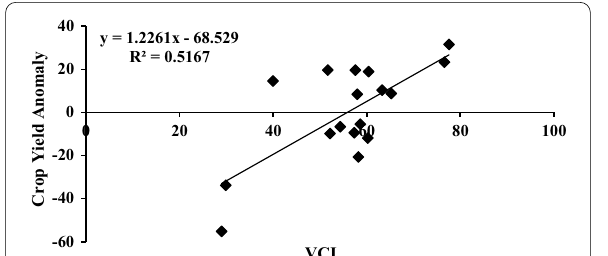
Fig. 9 Relation between VCI and crop yield anomaly